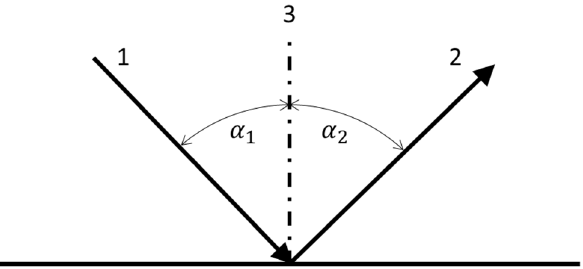
Figure 1. Spectral Figure 1. Spectral reflectance.